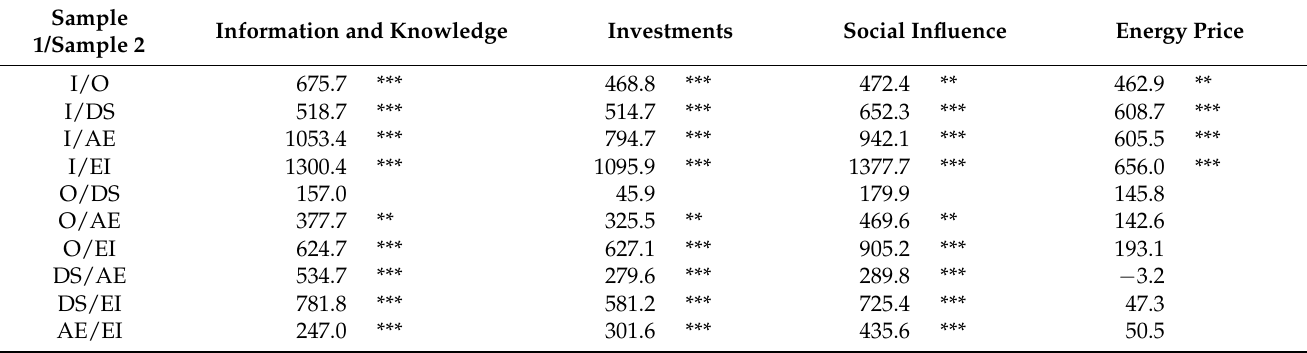
Table 5. Results of Post-hoc